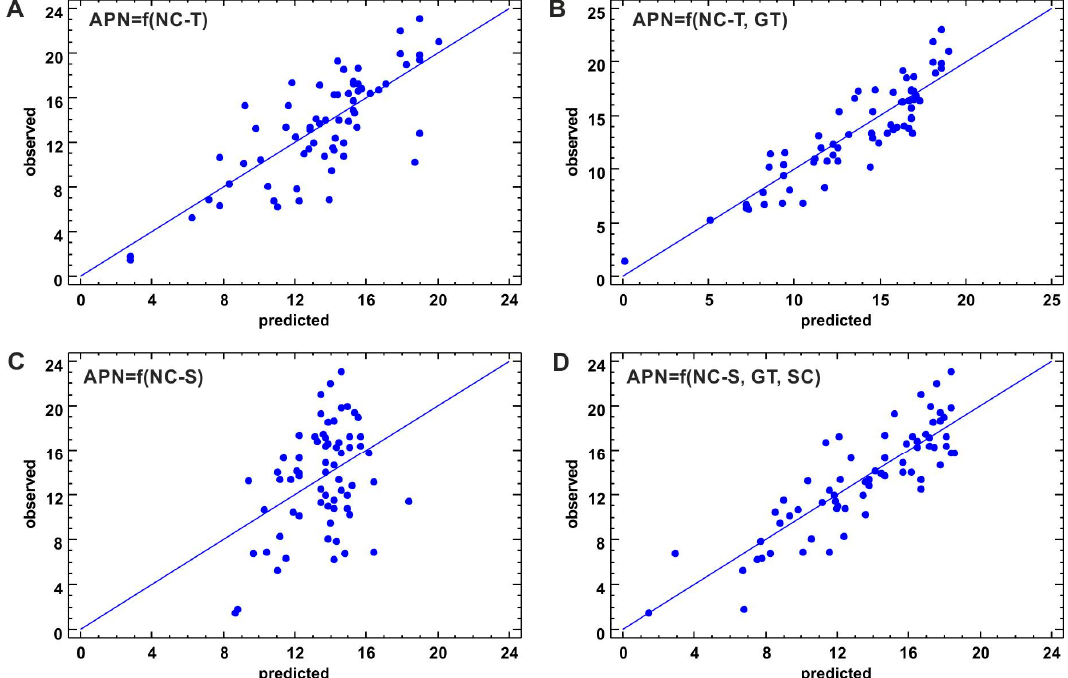
Figure 8. Scatter plots between predicted and observed APN; predicted APN was calculated based on grid photographs from the SLM ( A ) and GLM regression model ( B ) and based on seafloor photographs from the SLM ( C ) and GLM regression model ( D ).